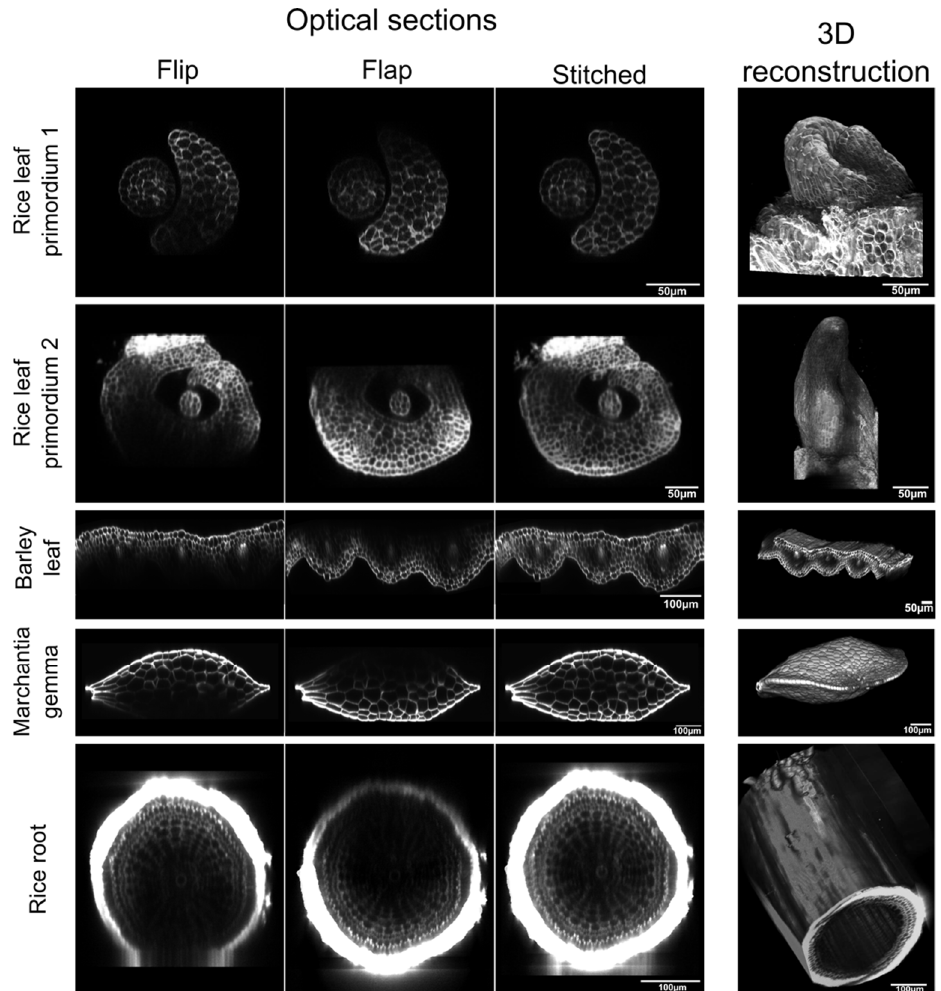
Figure 2. Optical sectioning of single or stitched stacks in different plant tissues. Visualization of optical cross-sections in Flip, Flap, and stitched stacks, along with the resulting 3D reconstructions generated using MorphoGraphX software. The samples were stained with Direct Red 23 (rice leaf primordia) or calcofluor (barley leaf, Marchantia gemma, and rice roots) according to established protocols. Scale bar: 50 µ m (rice and barley leaves); 100 µ m (Marchantia gemma and rice